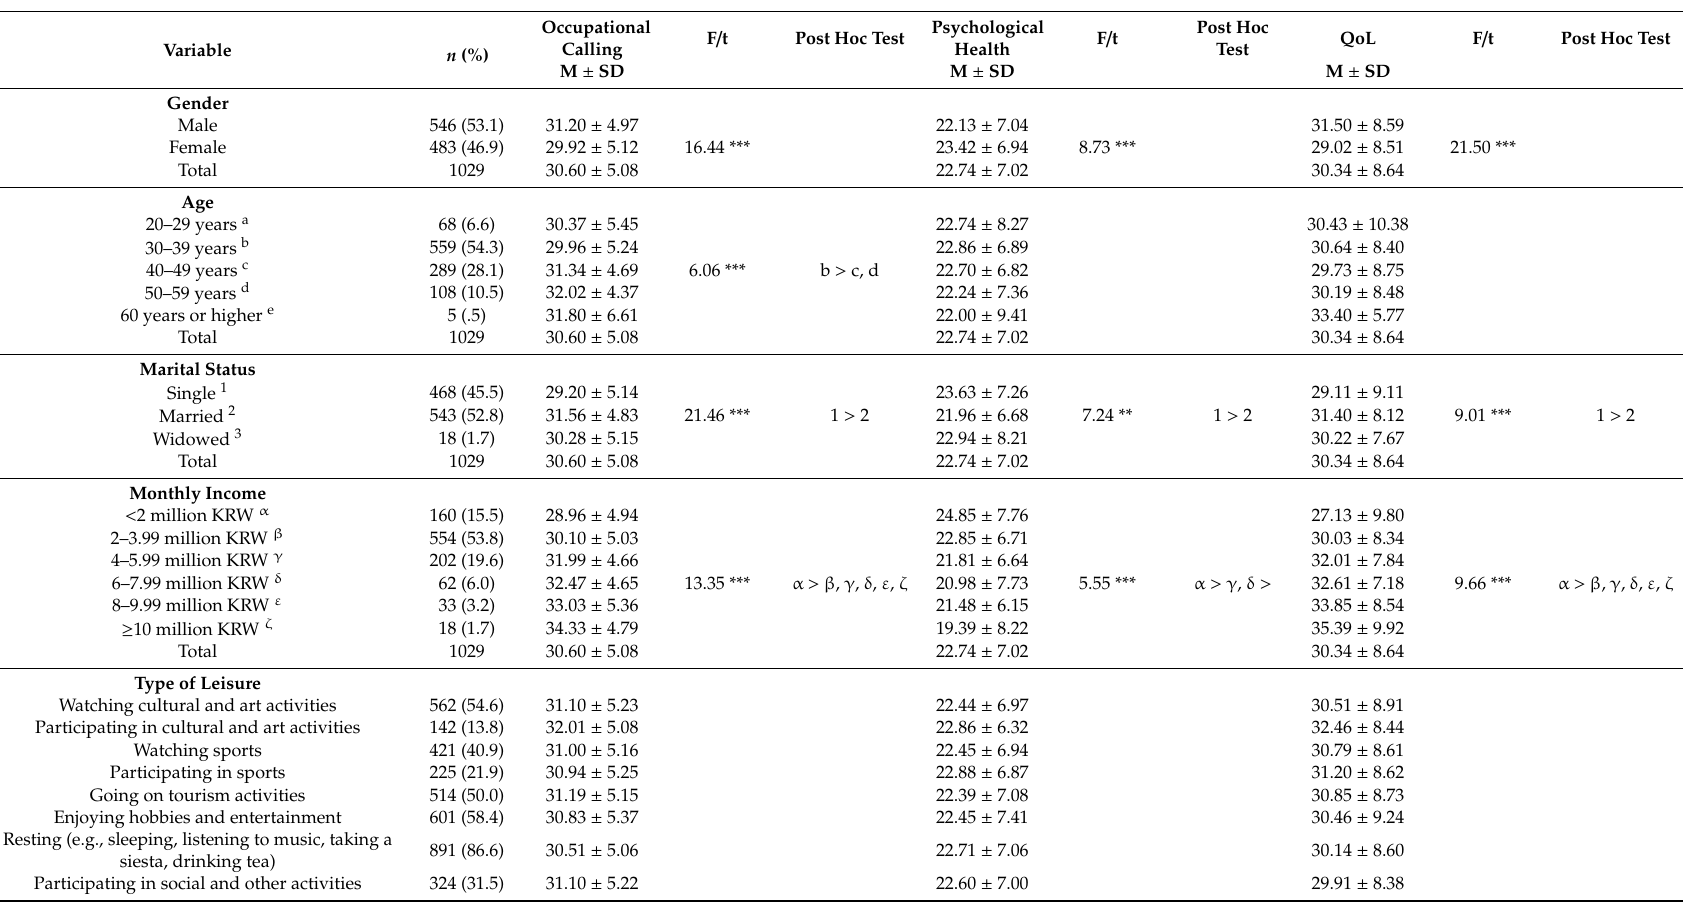
Table 2. Participants’ occupational calling, psychological health, and quality of life according to their sociodemographic characteristics ( N = 1029).